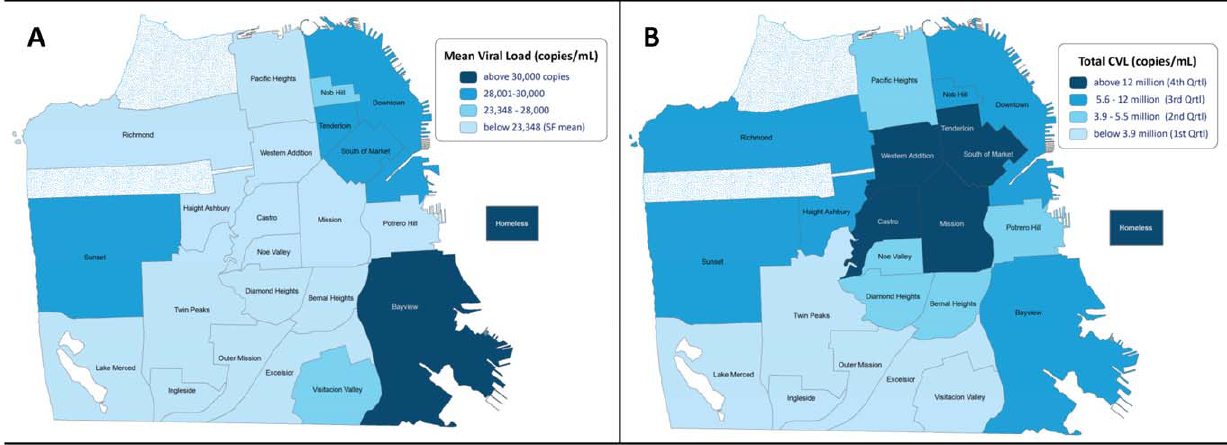
Figure 1. Spatial Distribution of CVL by Neighborhood, 2005–2008. Neighborhood mean (1a) and total CVL (1b) are shown. Mean CVL was highest among homeless individuals (38,974copies/mL; N=775; 6%). The highest mean CVL (38,428 copies/mL; N=278; 2%) was in the southeast neighborhood of Bayview, which is characterized by lower income and a predominantly African-American population. The northeast and inner city areas of the Tenderloin and South of Market (characterized by low income and large numbers of IDU, commercial sex workers, and transgendered persons) also had a mean CVL above the municipal average (28,093 copies/mL; N=1,486; 12%). The Castro neighborhood (an historic gay and relatively upper-income neighborhood with very high HIV/AIDS case density) had a mean CVL of 21,352 copies/mL (N=2,106; 17%), below the city as a whole. The distinction between mean CVL and total CVL is seen in 1b. The highest total CVLs are evident in the Tenderloin, South of Market, Mission, and the Castro, where there are either large numbers of persons living with HIV, many persons with high VLs, or a combination